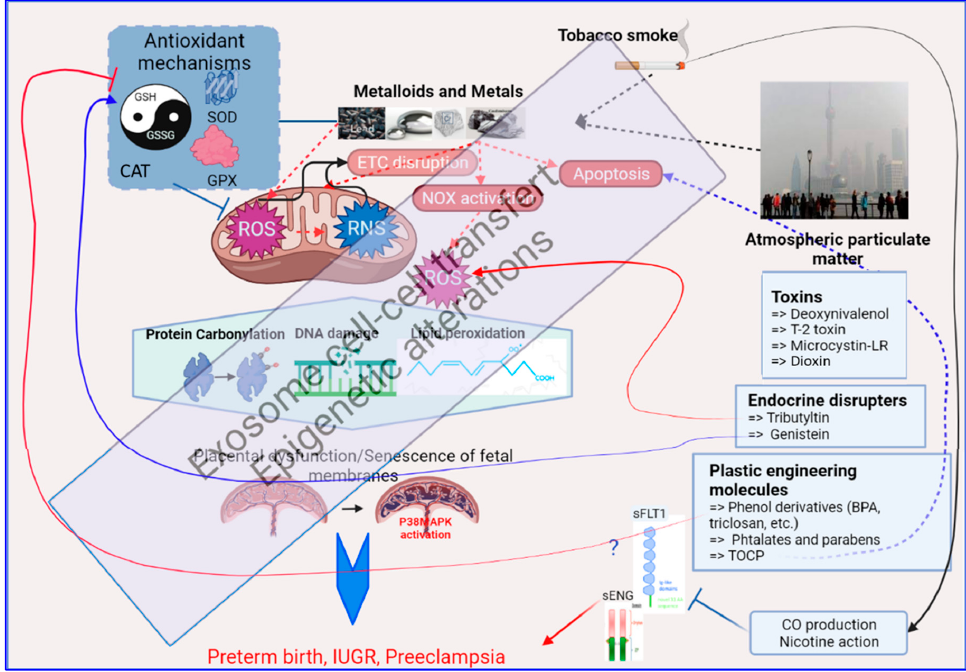
Figure 3. A brief graphic summary of the mechanistic impacts of environmental exposure through oxidative stress alterations in the human placenta, as detailed in the text of this review. At the center of this graph is the mitochondria which is the major producer of oxidative stress (ROS = Reactive Oxygen Species, and RNS = Reactive Nitrogen Species). The red dashed arrows relate to the generation of oxidative stress; the box on the upper left summarizes the antioxidant mechanisms that will fight against oxidative stress (the balance GSH/GSSG, the Superoxide Dismutases, the Glutathione peroxidases, the Catalase). The effect of OS on biomolecules appears on proteins, DNA and lipids as shown in the hexagon in the middle of the figure, with specific chemical modifications. Below, the placenta on which this review is focused is presented, part of the oxidative stress response being triggered in this organ by the activation of the P38/MAPK pathway. In black are the sources of oxidative stress in the human placenta that are described in this paper (Metalloids and Metals, Tobacco smoke and Atmospheric particulate matter). In Blue boxes at the right part of the figure are presented specific chemicals that are part of the placental regulation of oxidative stress, acting either on ROS production or modulation of ROS detoxification that is further detailed in the text. Other abbreviations: ETC = Electron Transport Chain, NOX = Nitric Oxidases, sFLT1 = Soluble FMS-Like Tyrosine kinase 1, sENG = soluble Endoglin, CO = Carbon Monoxide, TOCP = Tri-ortho- cresyl